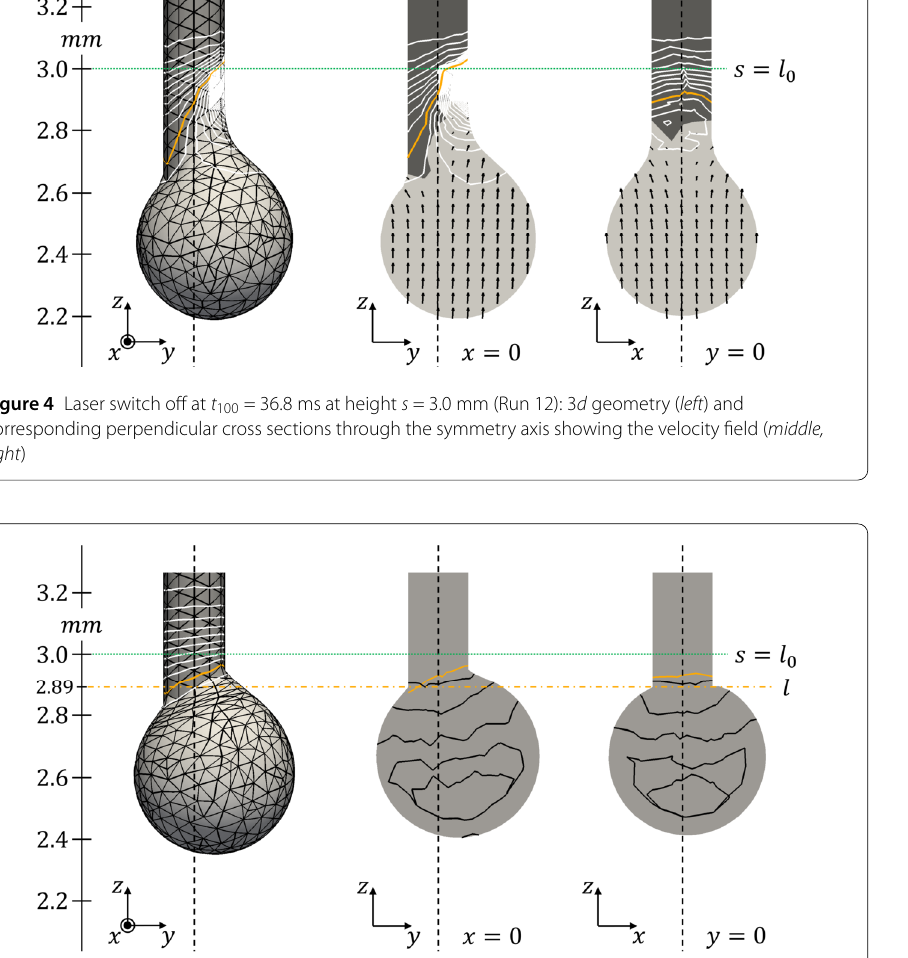
Figure 5 Solidification and estimated molten length l (Run 12): 3 d geometry at time instant t max = t 106 = 39.0 ms with maximal melt volume ( left ) and perpendicular cross sections of the final geometry at t 667 = 246 ms showing the solidification by isolines for T m at t { 106+ k · 100 } = 39.0 ms + k · 36.8 ms with k ∈ { 0,1, ... ,5 } ( middle,right